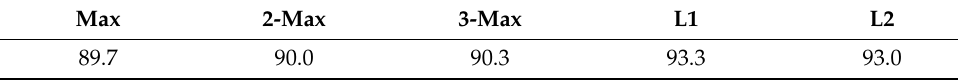
Table 1. The diagnosis results using different feature and standard SVM (%).